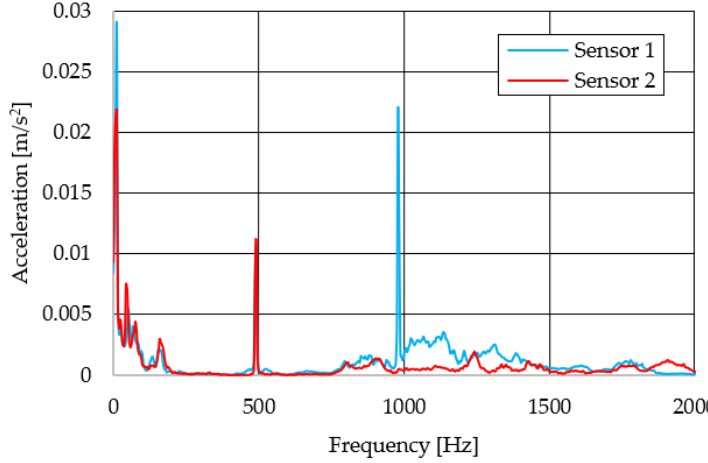
Figure 20. Comparison of the frequency waveforms in the x -axis during asymmetrical crossing over the obstacle by the left wheel.